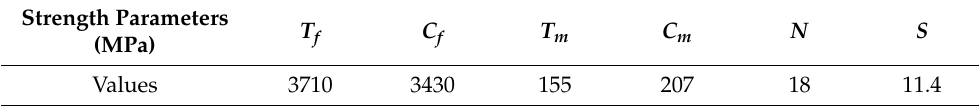
Table 2. Strength parameters for the constituents